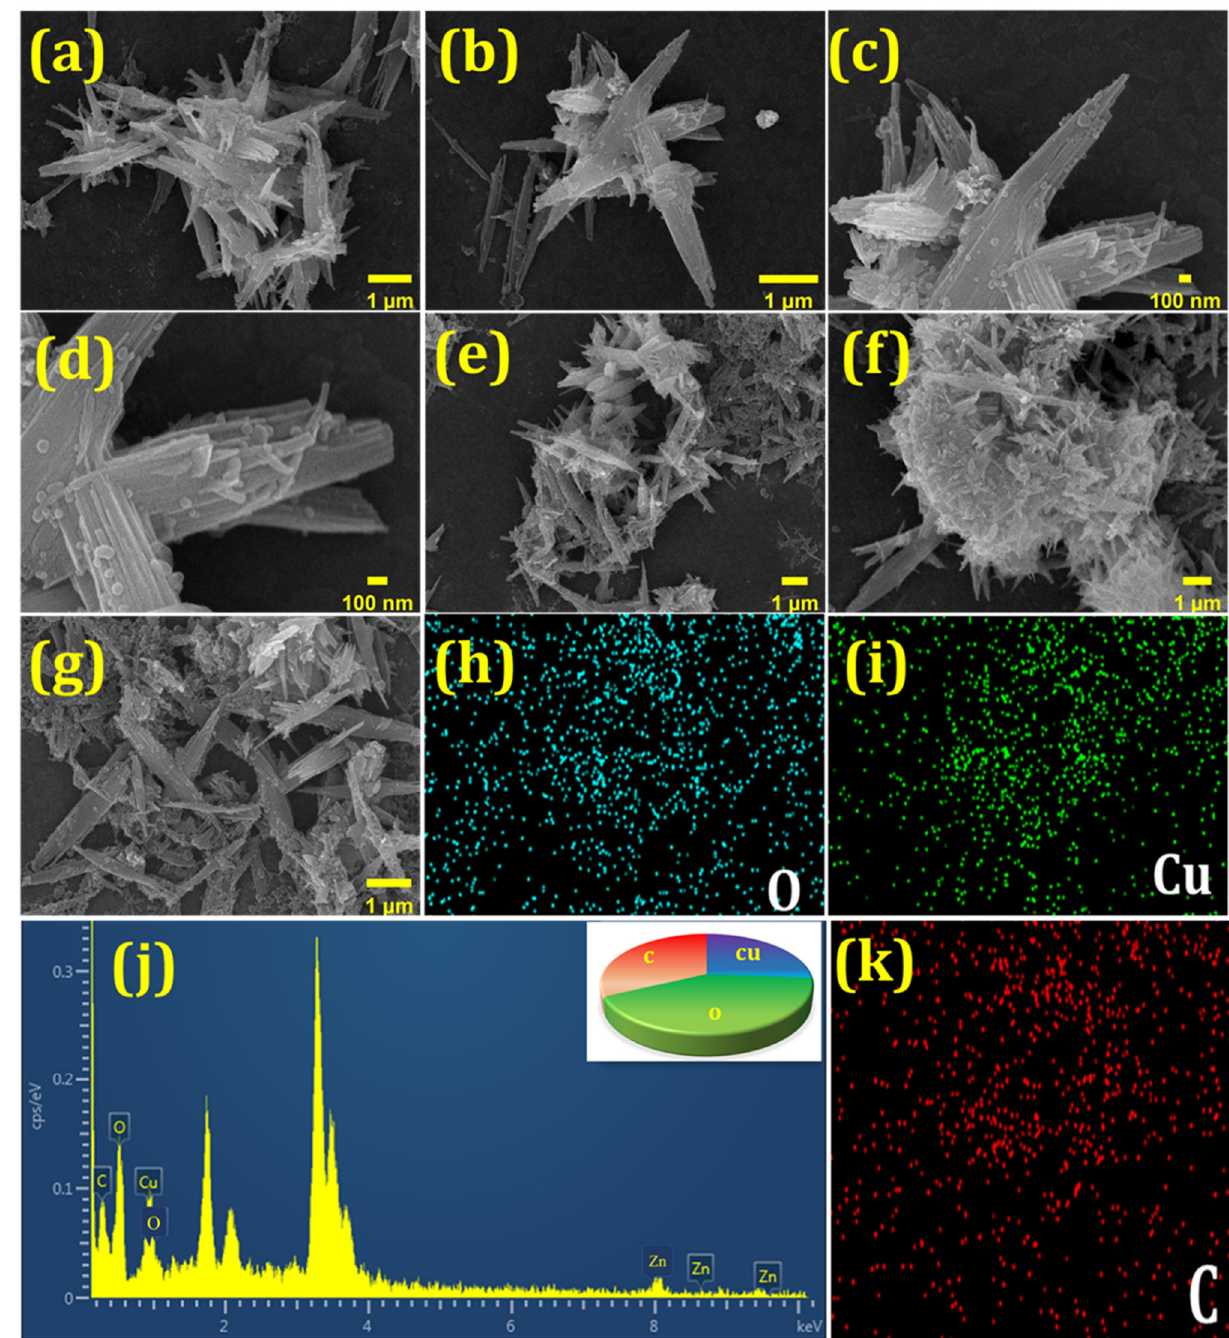
Figure 1. ( a – g ) FE-SEM images of Cu-BTC NWs. Mapping of ( h ) oxygen, ( i ) copper, and ( k ) carbon. ( j ) EDX analysis of Cu-BTC NWs. ( j ) EDX analysis of Cu-BTC